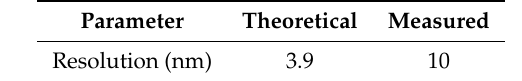
Table 3. Comparison of the theoretical resolution with the measured